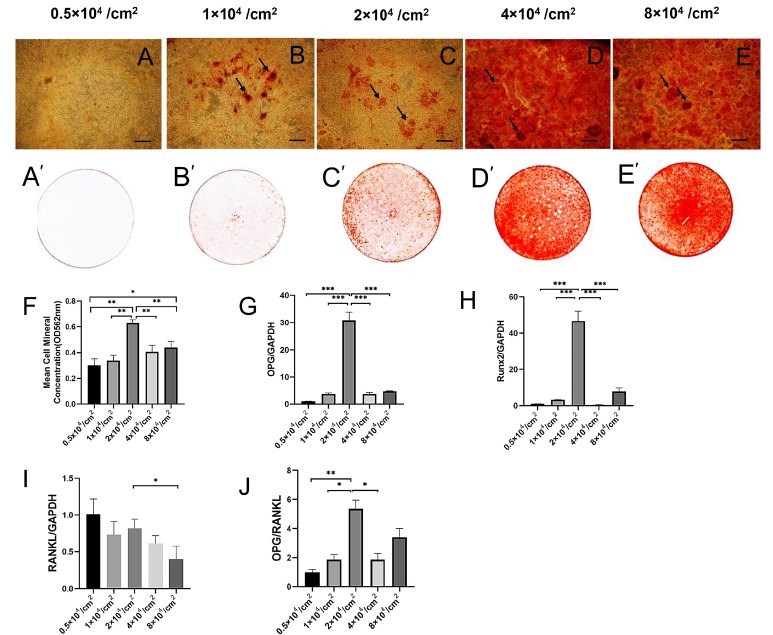
Figure 2. Effect of initial cell density on osteogenesis induction of hPDLSCs over 14 days. Calcium nodules produced through hPDLSC osteogenesis induction were observed under light microscope at different initial culture densities. The black arrows represent calcium nodules. ( A – E ) Overview of hPDLSC osteogenesis induction at different initial culture densities. ( A’ – E’ ) Single-cell mean cal- cium concentration produced by hPDLSC osteogenesis induction in the 2 × 10 4 /cm 2 cell density group was the highest. ( F , p < 0.05). The expressions of OPG and RUNX2 and the OPG/RANKL ratio were the highest in the 2 × 10 4 /cm 2 group ( F – J ). ( p < 0.05). * indicates p < 0.05, ** indicates p < 0.01; *** indicates p < 0.001. Scale bar = 50 µm. The gene expressions of OPG, RUNX2, and RANKL were further determined by RT- PCR. On the fourteenth day of osteogenesis induction, the expression of the OPG (Figure